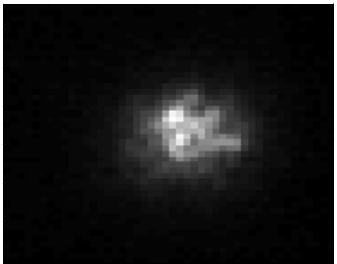
Figure 2. Image of a laser spot over a rough surface. The localization of the centre cannot be done without certain uncertainty, due to the speckle effect (courtesy of